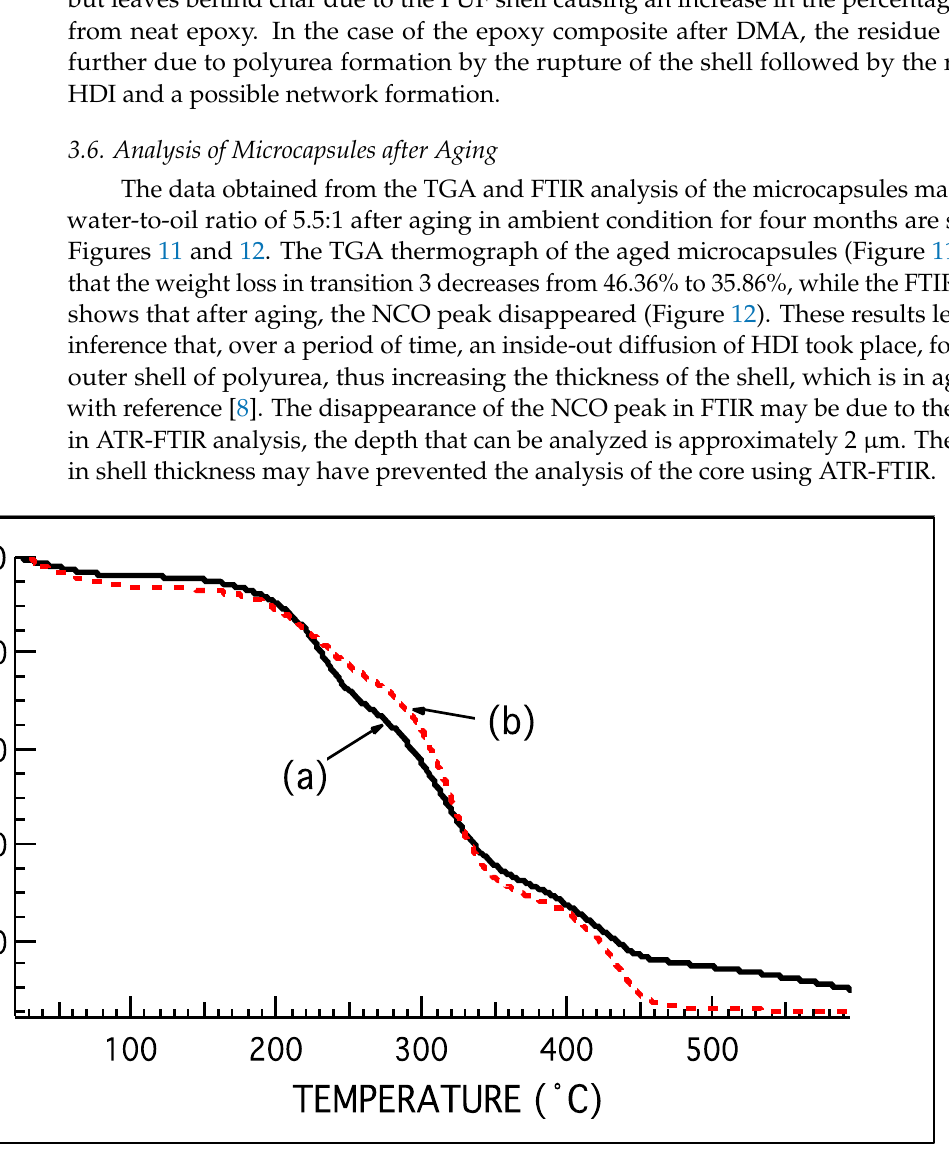
Figure 11. TGA of microcapsules with a water:oil ratio of 5.5:1 compared with TGA of the same microcapsules after aging for 4 months. (a) Percentage weight of microcapsules aged for 4 months; (b) Percentage weight of original microcapsules.